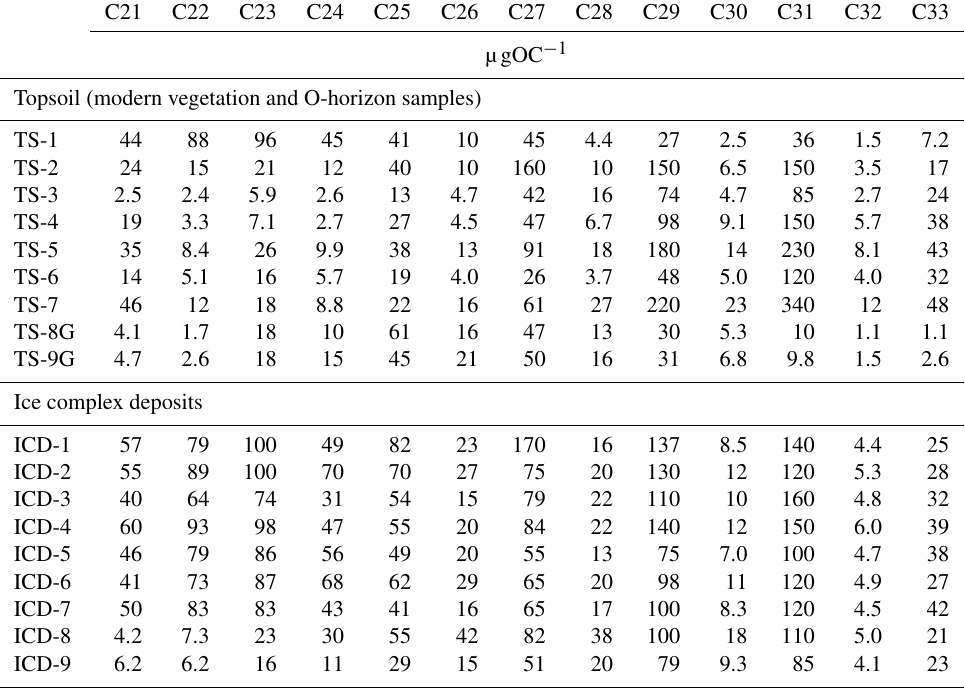
Table 2. Long-chain n -alkane concentrations (in µggOC − 1 ) of topsoil Holocene samples (modern vegetation and O horizon) and Pleistocene ice complex samples.